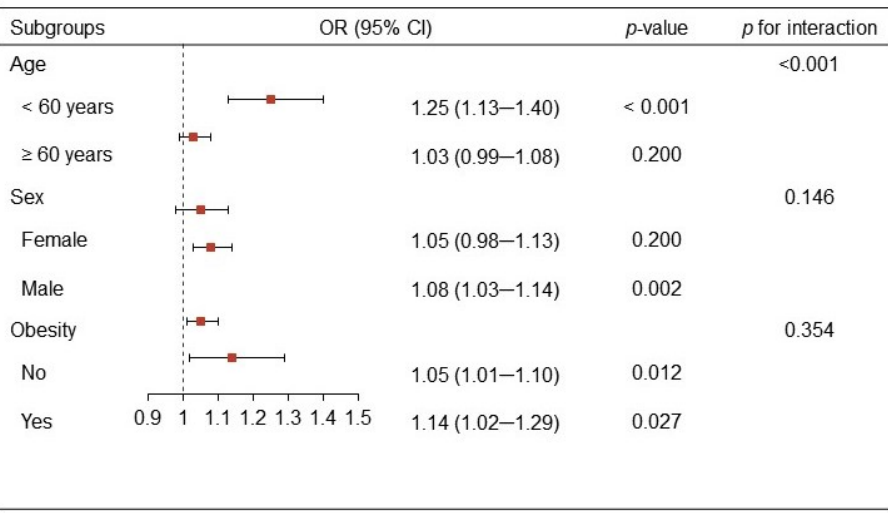
Figure 4. Subgroup analyses of the association between aortic calcification index (ACI) and urinary stones by age (<60 years or ≥ 60 years), sex (female or male) and by obesity (no or yes). The models were adjusted for CHD, triglycerides, glucose, serum creatinine, uric acid, urea, calcium, and eGFR.